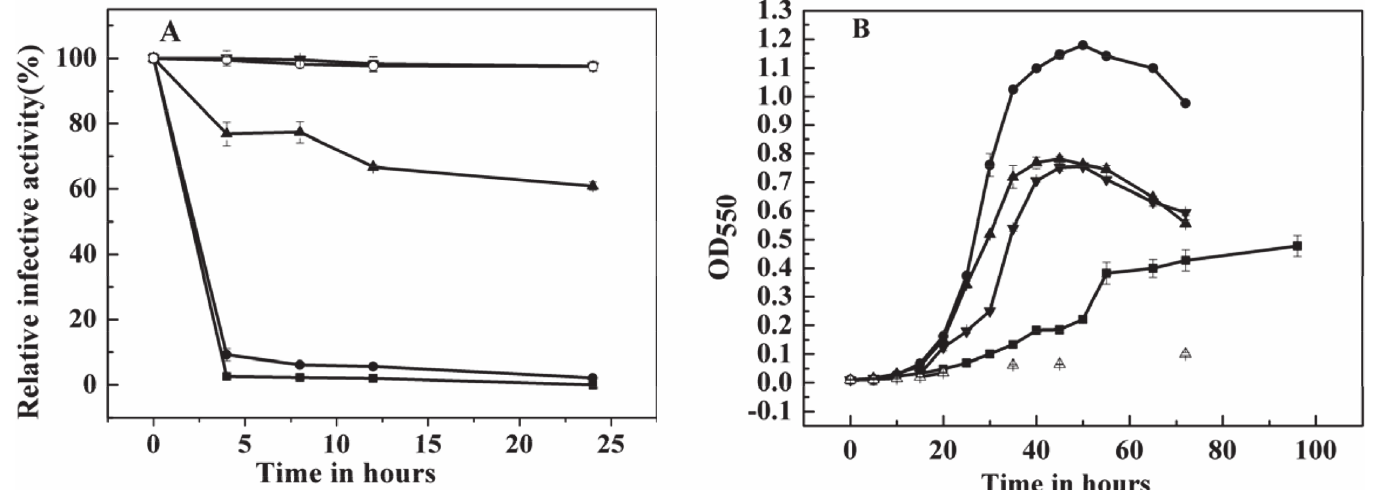
Fig 1. The effect of salinity on the infective activity of halovirus SNJ1 and the growth of its host cells. (A) the remaining infective activity of halovirus SNJ1 under different NaCl concentrations at indicative time; ■ , ● , ▲ , ▼ , and (cid:4) represent the remaining infective activity in 12%, 15%, 18%, 25%, and 30% NaCl, respectively. (B) the growth curves of Natrinema sp. J7-2 under different NaCl concentrations at indicative time; the symbols 4 , ■ , ● , ▲ , and ▼ denote the growth of the host cells in 12%, 15%, 18%, 25%, and 30% NaCl, respectively.